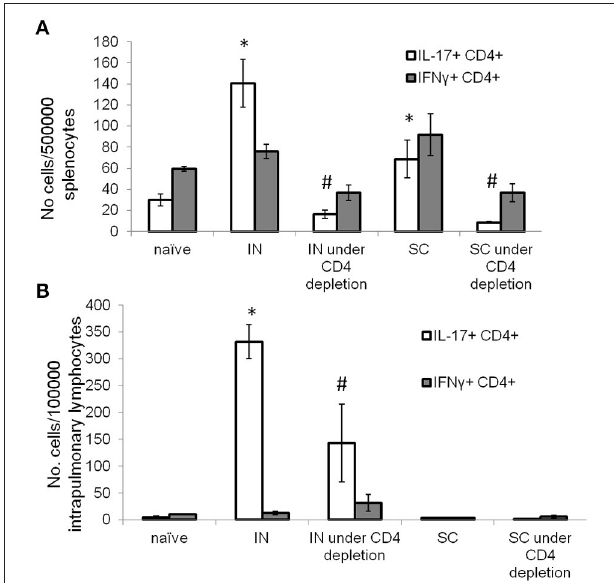
FIGURE 4 | Intranasal DnaK vaccination generates antigen-specific IL-17 + CD4 + T cells in CD4-deficient mice. Control C57BL/6J mice were vaccinated with DnaK (100 µ g) by subcutaneous injection or DnaK (20 µ g) by intranasal injection then repeatly vaccinated again 2 week later. Separate group of mice were vaccinated as above, but also received anti-CD4 + neutralizing antibody 1 day before and during vaccination. Intrapulmonary T cells and splenocytes were analyzed 2 weeks after the last vaccine dose. Splenocytes (A) and intrapulmonary T cells (B) were stimulated with recombinant DnaK (10 µ g/ml) and antigen-specific CD4 + T cells were evaluated for IFN γ and IL-17 secretion by intracellular cytokine staining. Mean ± SEM, N = 3–4, * p < 0.05 compared to compared to the other two groups. # p < 0.05 compared to SC and IN